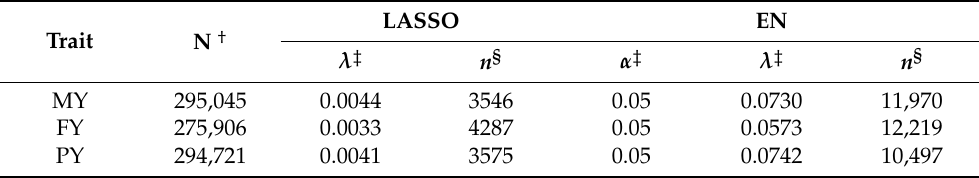
Table 1. Optimal parameter values and results of feature selection with LASSO and EN. LASSO EN Trait N † λ